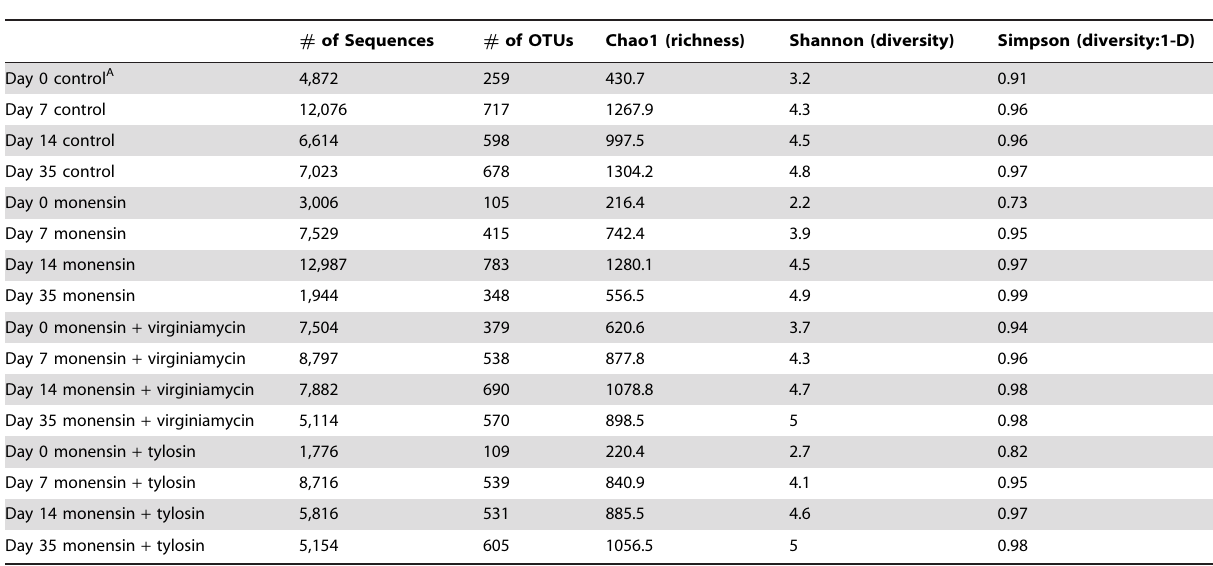
Table 1. Number of OTUs per groups and estimators of sequence diversity and